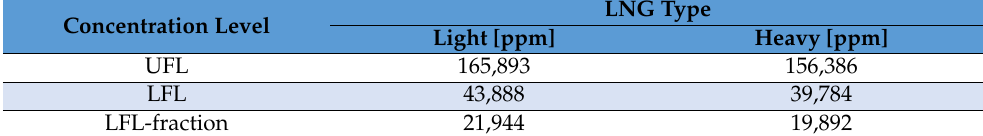
Table 2. Concentrations corresponding to the upper (UFL) and lower flammability limit